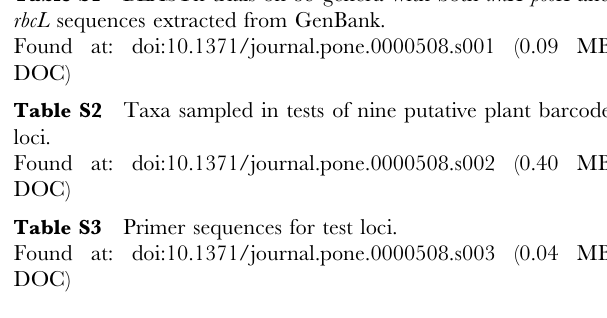
Table S1 BLASTn trials on 59 genera with both trnH-psbA and rbcL sequences extracted from GenBank.